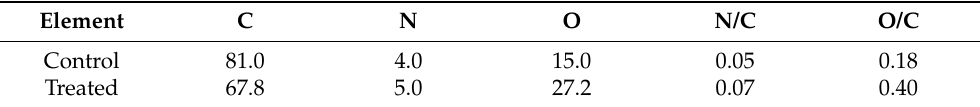
Table 2. Atomic concentrations of the selected elements present in H 2 O-LPP-treated and -untreated Bambara groundnut seeds.